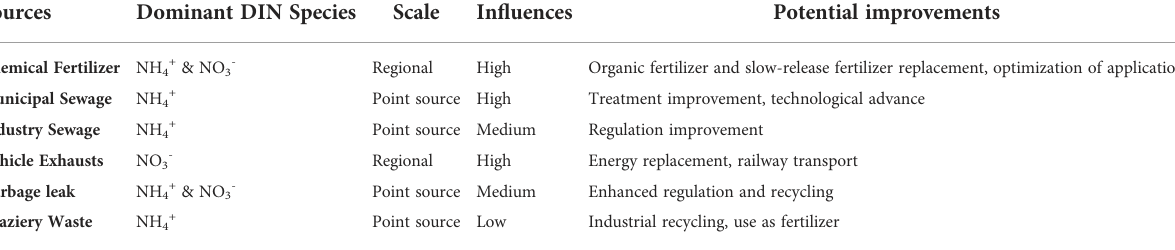
TABLE 1 Anthropogenic Nitrogen sources and potential approaches to reduce DIN emissions to tropical coastal